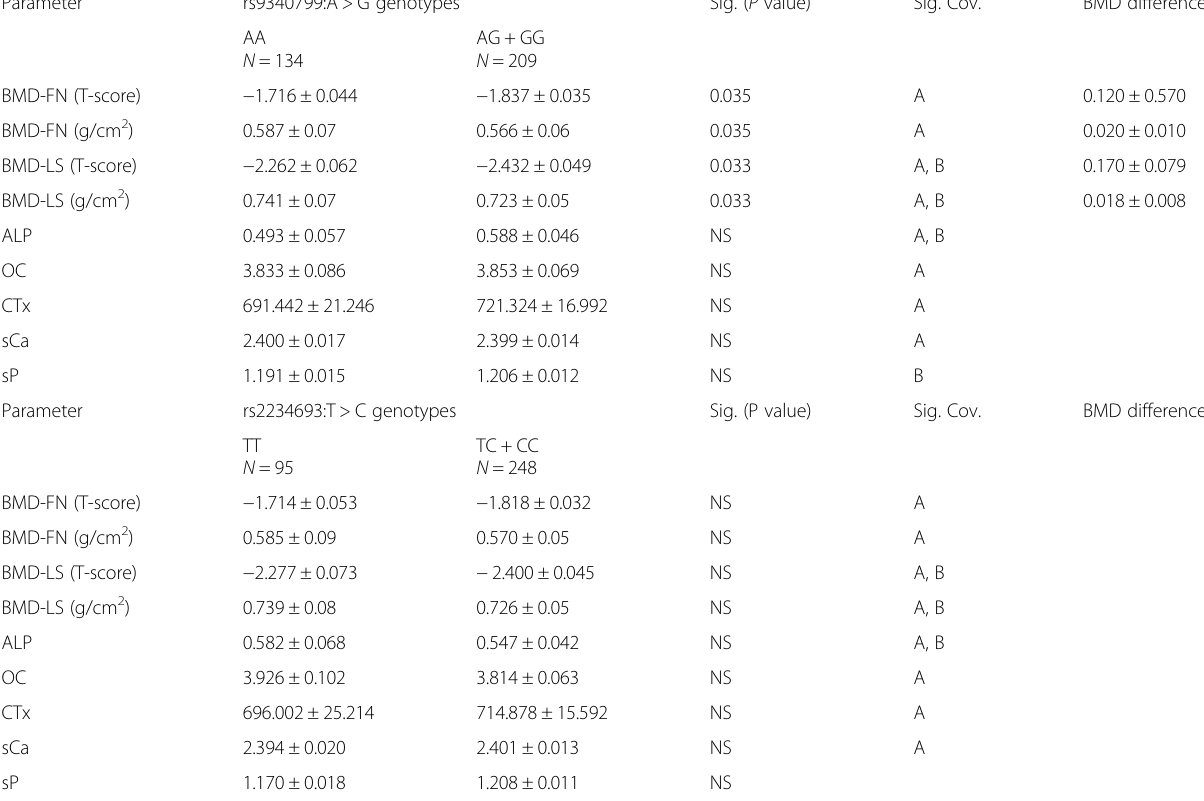
Table 3 Associations of the rs9340799 and rs2234693 genotypes with osteoporosis-related traits